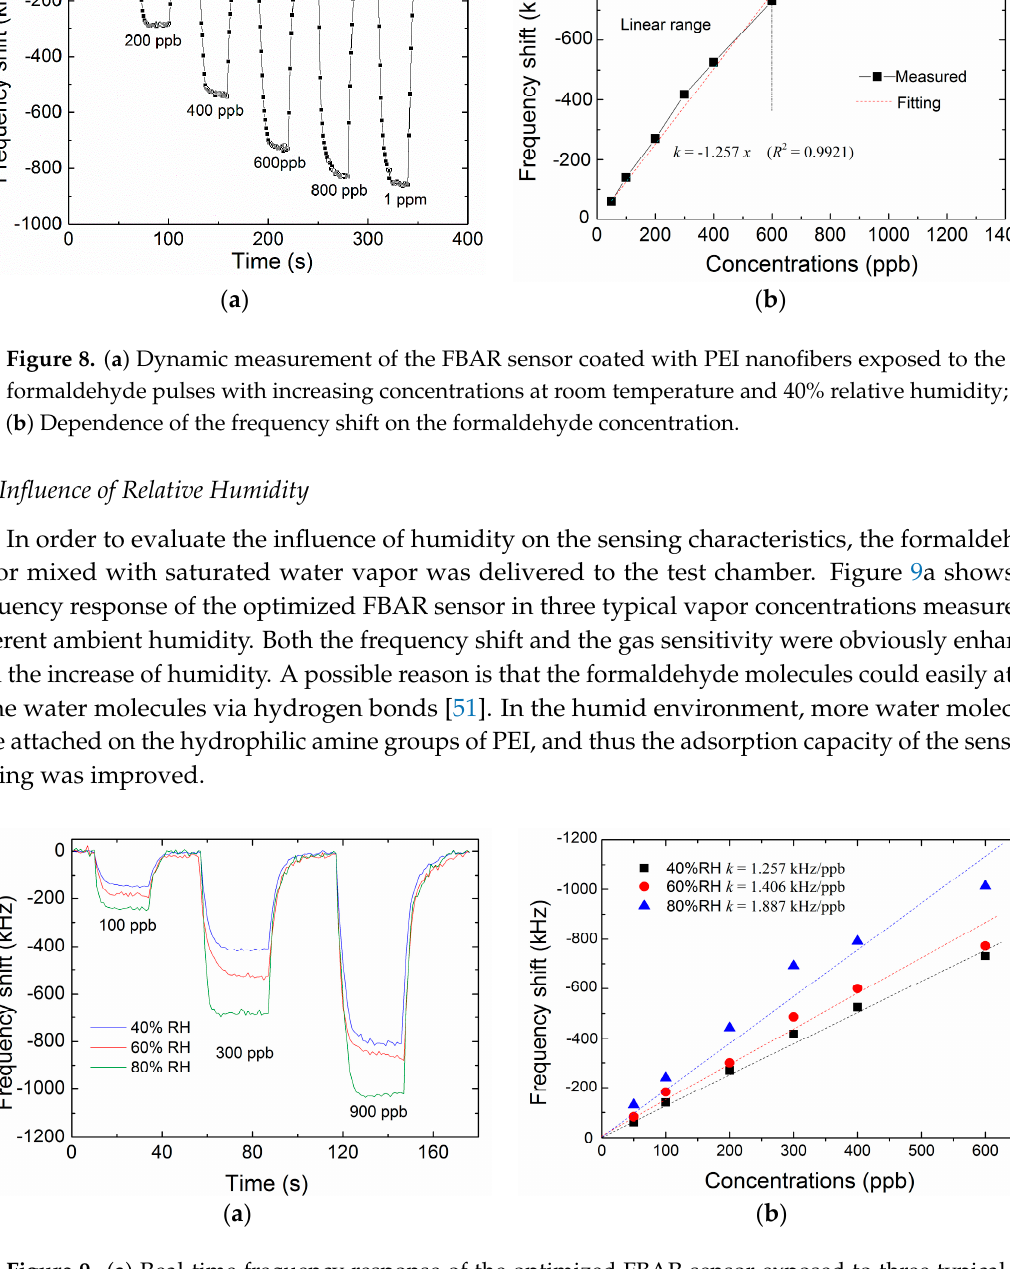
Figure 9. ( a ) Real-time frequency response of the optimized FBAR sensor exposed to three typical formaldehyde concentrations at the relative humidity of 40%, 60% and 80%. ( b ) Plots of frequency shift as a function of formaldehyde concentration at the relative humidity of 40%, 60% and 80%.